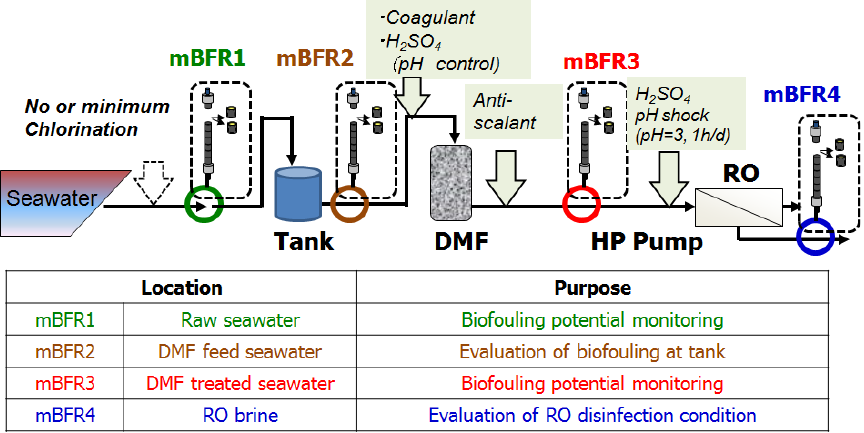
Figure 7. Evaluation points of membrane biofilm formation rate (mBFR) in the pilot testing.